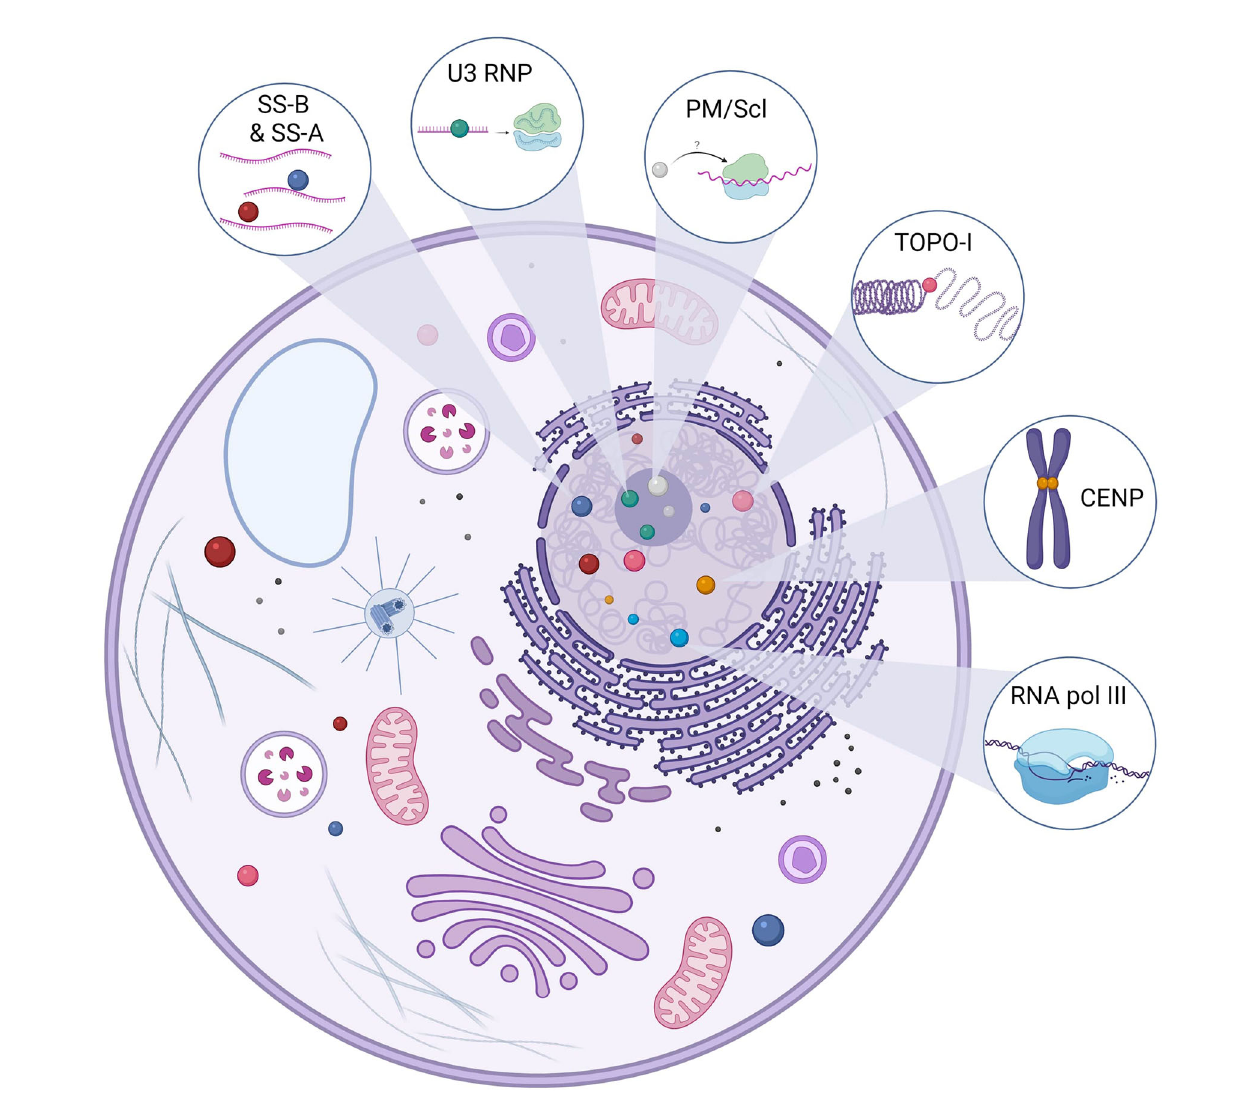
FIGURE 1 | Main antigenic targets of ANA in SSc. Anti-topoisomerase-I autoantibodies (Aab) are speci fi c to systemic sclerosis (SSc). Topoisomerase-I is involved in the DNA relaxation and can be found in the nucleus but also the cytoplasm. There are several centromeric proteins, but three can be targeted by SSc Aab: CENP-A (17 kDa), CENP-B (80 kDa), and CENP-C (140 kDa). CENP-B is the main antigen target, and ACA can recognize other epitopes. Anti-U3 RNP or anti- fi brillarin Aab recognize a 34-kDa protein in the U3-RNP complex in the nucleolus. U3 RNP has a role in the transcription of ribosomal RNA. Pm/Scl is in the nucleolus and is a complex of 11 – 16 proteins; the 75 and 100 kDa proteins are the main targets of these Aab. Although their precise role remains to be elucidated, they are thought to be involved in the ribosome synthesis. RNA polymerase III is involved in the DNA transcription of RNA and is in the nucleus. Anti-SS-A Aab are directed against two proteins of different molecular masses, namely, 52 and 60 kDa, and those proteins are part of different macromolecular complexes. Ro60 is part of a ribonucleic complex involved in the regulation and transcription of mRNA and Ro52 (also known as TRIM21) and plays a role in the immune response by acting as a cytosolic sensor during viral infection. SS-B or La protein is a protein involved in the maturation of transcripted RNA by RNA polymerase III. The anti-SS-B Aab is always associated with anti-SS-A Aab. Those ANA (SS-A and SS-B) can be found in the nucleus but also in the